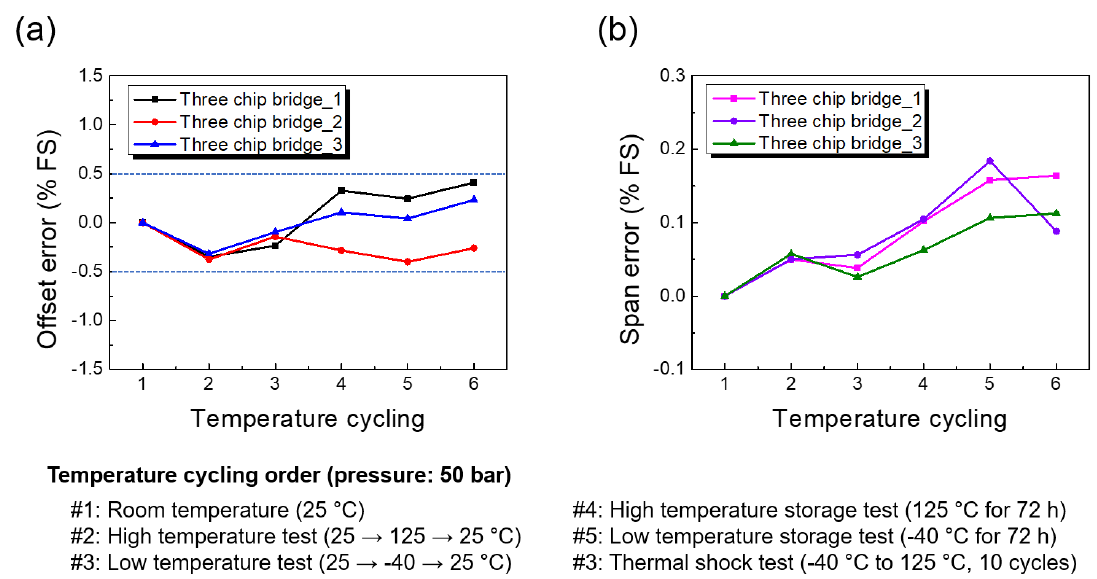
Figure 16. Variations in offset ( a ) and span ( b ) errors after temperature cycle/shock tests.